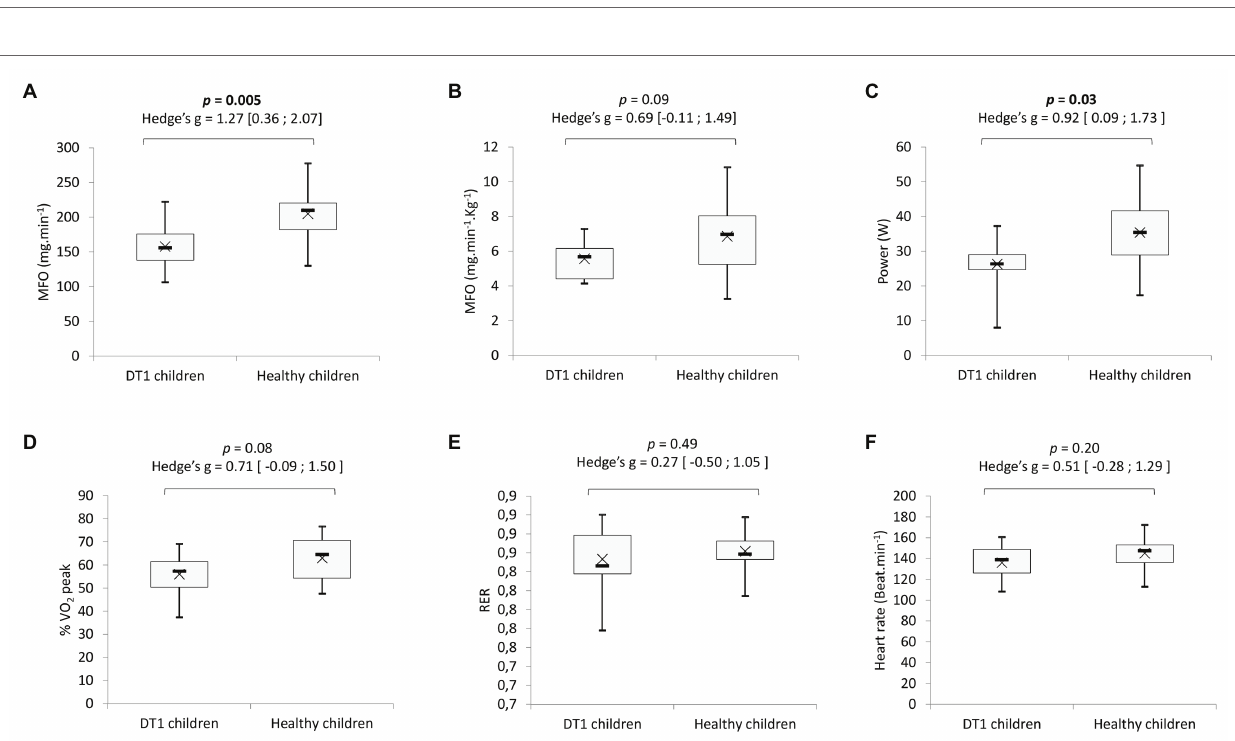
FIGURE 2 | The oxidation rates of carbohydrates (A) and fat (B) , in conjunction with power output (C) according to the percentage of VO 2 peak. Individual regression for heart rate (HR) vs. the corresponding relative VO 2 peak for children with type 1 diabetes mellitus (T1DM) and healthy controls (D) . Data are means ± SD.